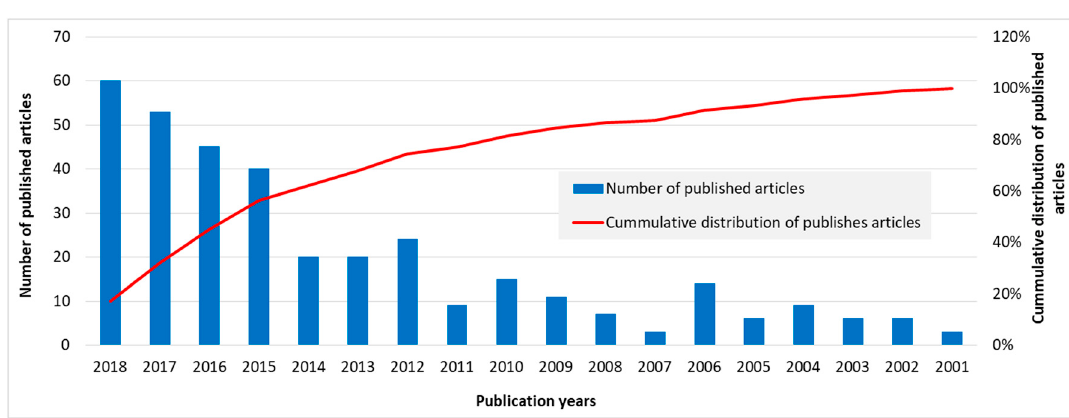
Figure 2. Classification of articles by year of publication based on search in Web of Science.